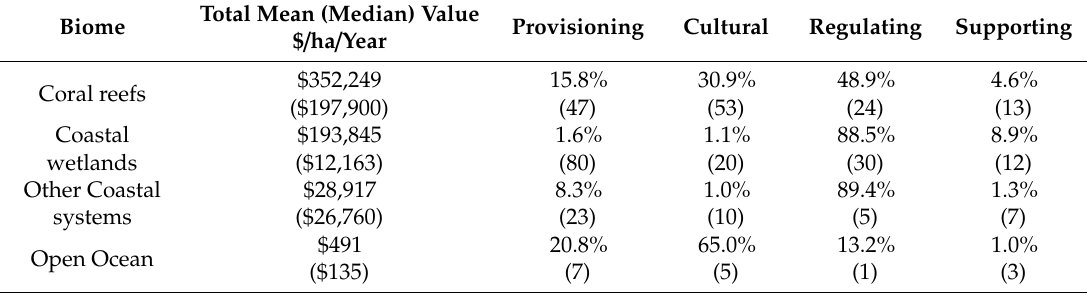
Table 2. Ecosystem service components as a percent of total mean value (in 2007 Int.$ / ha / year) for coastal and marine biomes; number of value estimates in parentheses below each percent. Adapted from: